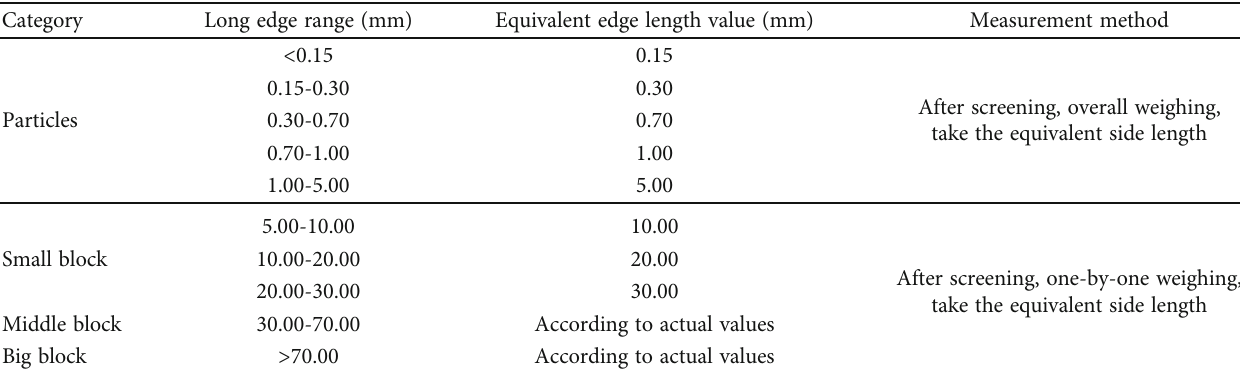
Table 2: Table of scale reference